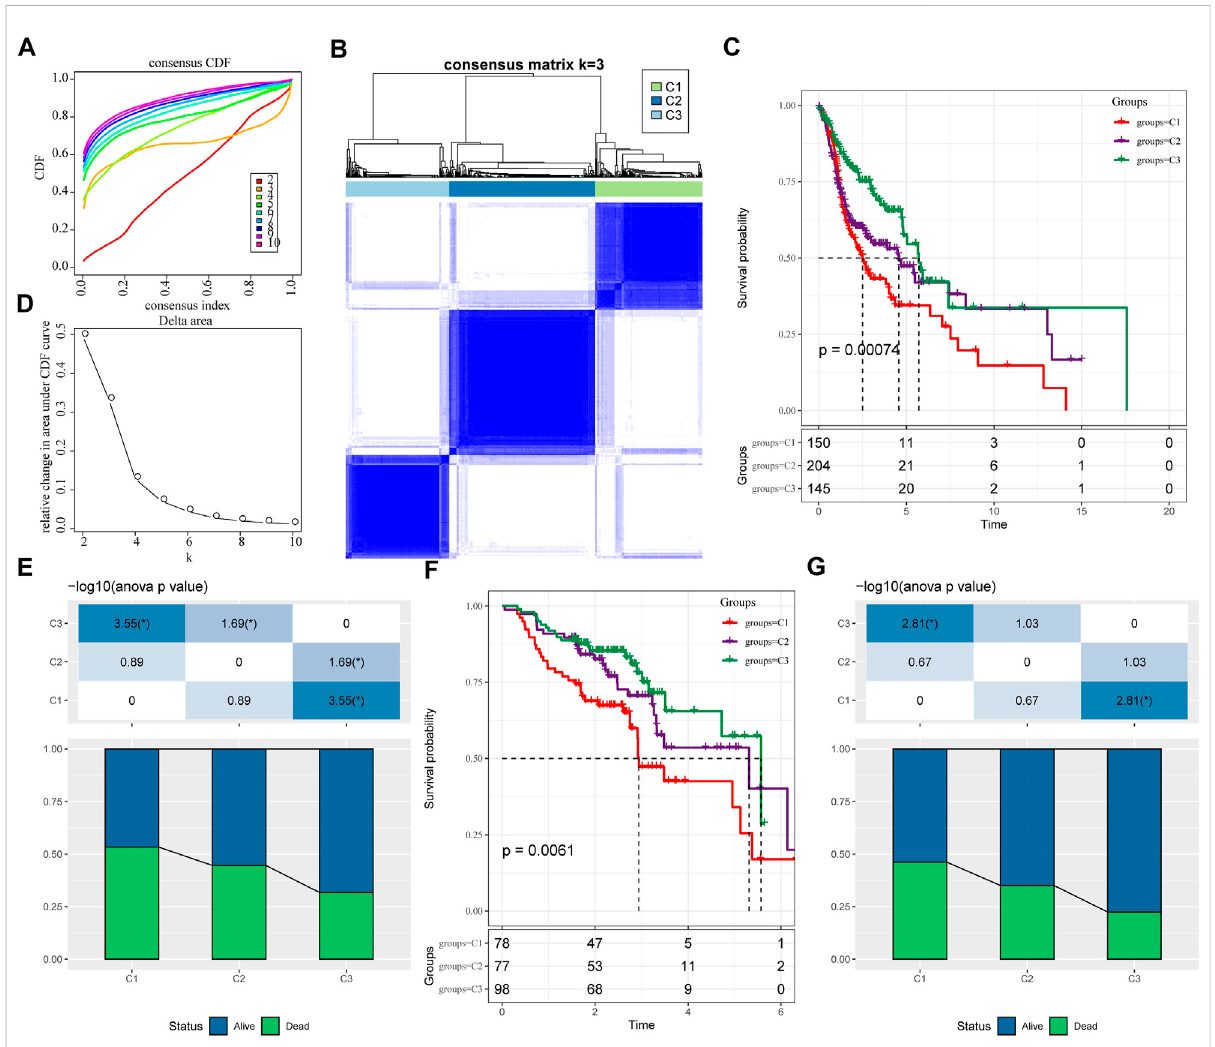
FIGURE 1 Molecular typing based on ferroptosis-related genes. (A) the cumulative distribution function (CDF) curve of TCGA-HNSC cohort sample; (B) the CDF Delta area curve of TCGA-HNSC cohort sample. Delta area curve of consensus clustering, indicating the relative change in area under the CDFcurveforeachcategorynumberkcomparedwithk – 1.Thehorizontalaxisrepresentsthecategorynumberkandtheverticalaxisrepresentsthe relative change in area under CDF curve; (C) Consensus heat map of sample clustering when k = 3; (D) Prognosis of three subtypes Relational Kaplan-Meier curve. (E) In TCGA-HNSC Differences in survival status of different subtypes; (F) the differences in prognosis of three molecular subtypesinGSE65858cohort; (G) DifferencesinsurvivalstatusofdifferentsubtypesinGSE65858.Thelowerhalfistheproportion,andtheupperhalf is the statistical signi fi cance of the distribution difference between the two pairs — log10 ( p